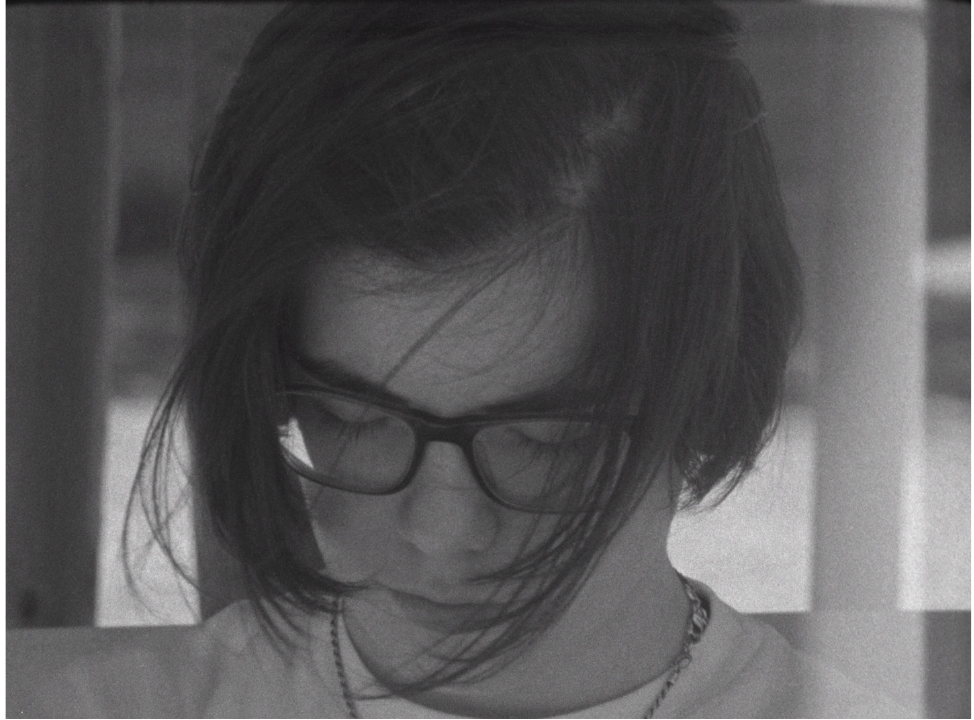
Figs. 7 – Still from 13 Ways of Looking at a Blackbird (2021). Courtesy of the